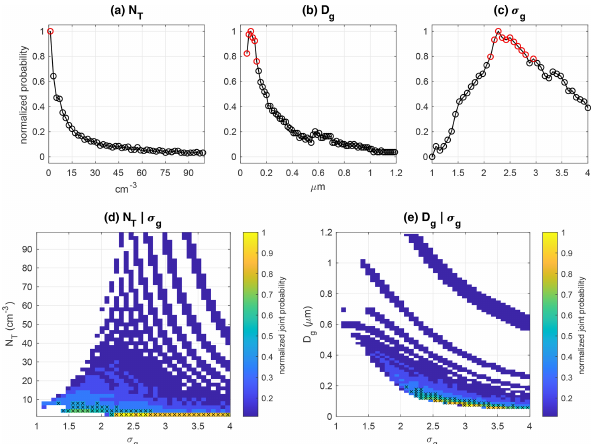
Figure 6. (a–c) Normalized probability distributions of sea spray mode fitting parameters obtained for one retrieval (3 Decem- ber 2016 at 22:00UTC). (a–c) Fitting parameter values with an oc- currence probability of greater than 75% are symbolized by red cir- cles. (d–e) Normalized joint probabilities (color bar) for fitting pa- rameter combinations of N T | σ g and D g | σ g from the same retrieval. Mie solutions that are within the top 5th joint probability percentile for each combination are symbolized by black